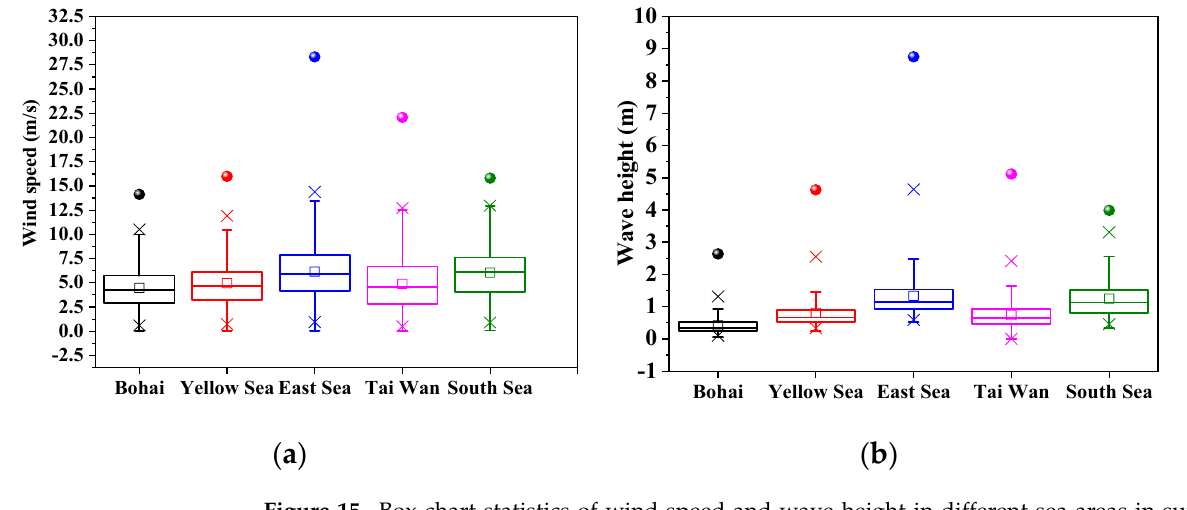
Figure 15. Box chart statistics of wind speed and wave height in different sea areas in summer 2015– 2017. ( a ) Wind speed; ( b ) wave height.